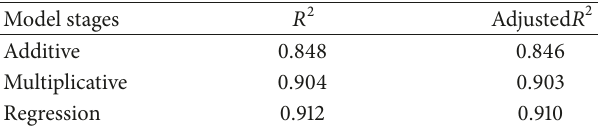
Table 24: Modeling accuracy of each stage.